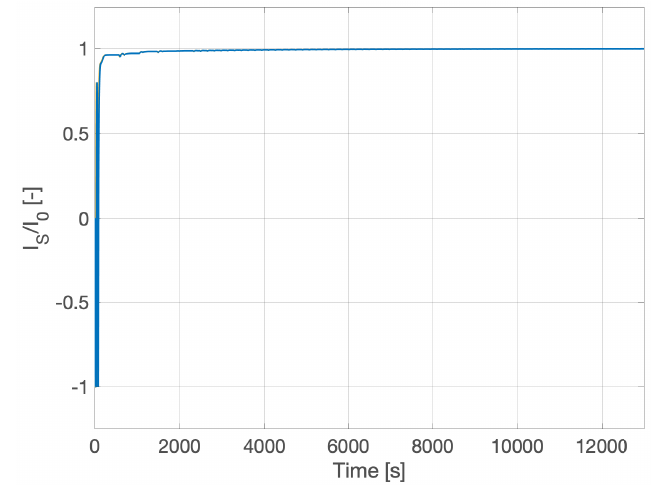
Figure 3. Specific solar arrays current, with no eclipses.